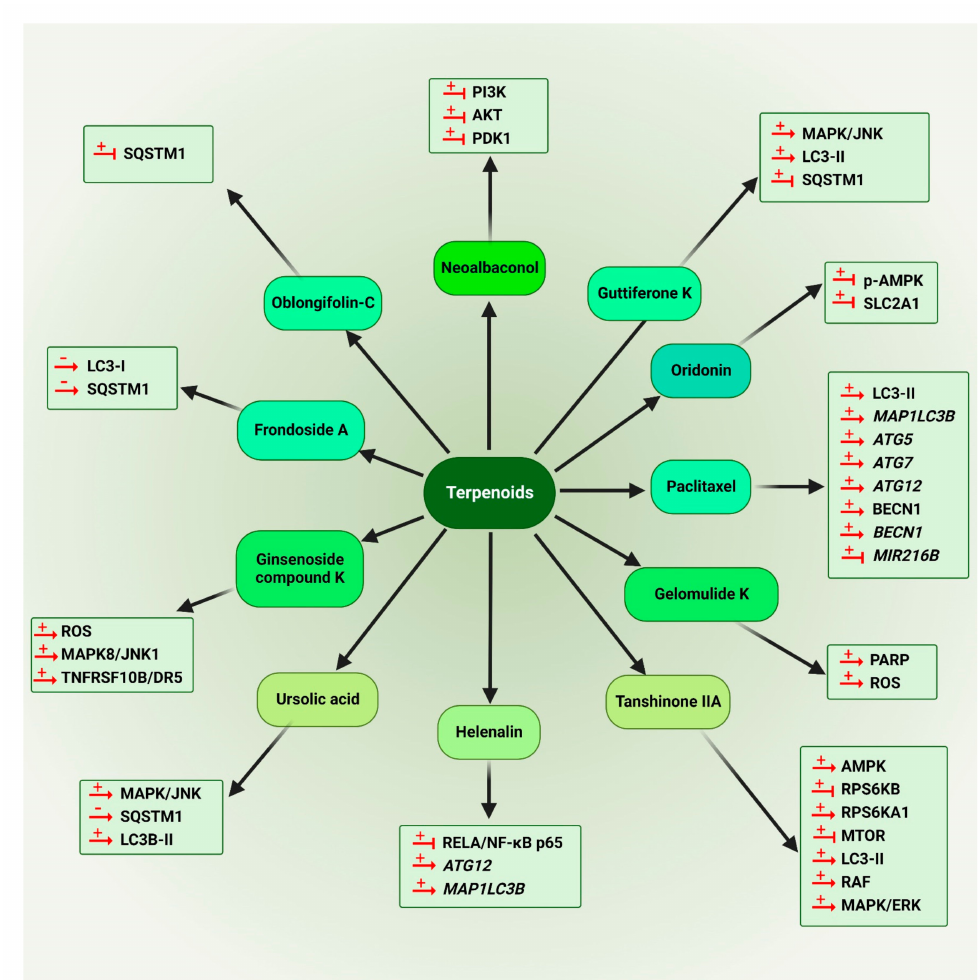
Figure 7. The schematic role of alkaloids on different proteins involved in the autophagy pathway. Alkaloids regulate autophagy in different ways. Vincristine and carbazoles have been demonstrated to inhibit autophagy by suppression of CD24, suppression of the PTEN-AKT-MTOR pathway and enhancement of SSQTM1/p62. Other alkaloids induce autophagy via activation of AMPK, TSC2, MAPK/JNK-AP-1 and BECN1, and enhance MYC/c-Myc, LC3-II and ATG7 expression. Moreover, inhibiting the AKT-MTOR pathway has a key function in induced autophagy by alkaloids. Moreo- ver, another alkaloid named tetrandrine induces autophagy by suppressing the WNT- CTNNB1/β - catenin pathway and decreasing MTA1 expression. → : Indicates activation or an increase in the mentioned protein expression. : Indicates deactivation or a decrease in the mentioned protein expression. − and +: Indicate the effect of the proteins on different pathways ( − means negative effect and + means positive effect). The figure was created with BioRender.com. Licensing Right AI24OB6U1K, 21 November 2022.